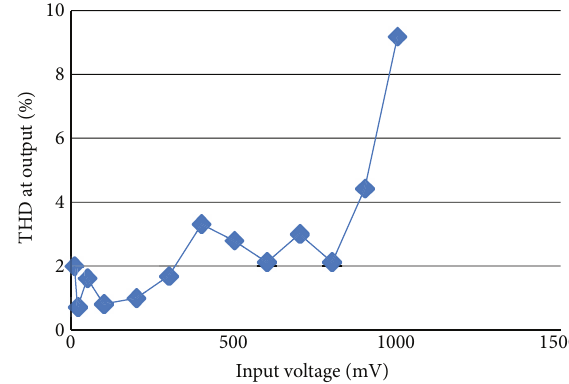
Figure 9: THD variation at output with signal amplitude at 15.92 MHz.